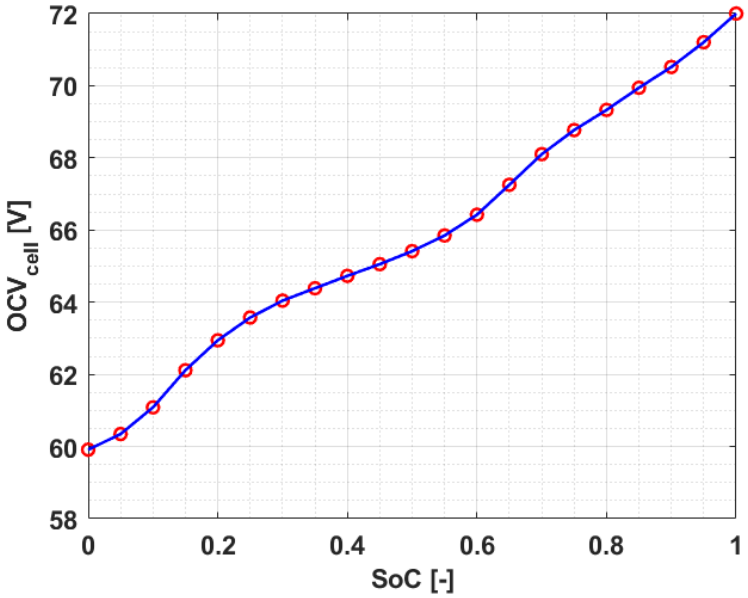
Appl. Sci. 2021 , 11 , 9316 Figure 5. Battery cells open-circuit voltage as a function of the state of charge.